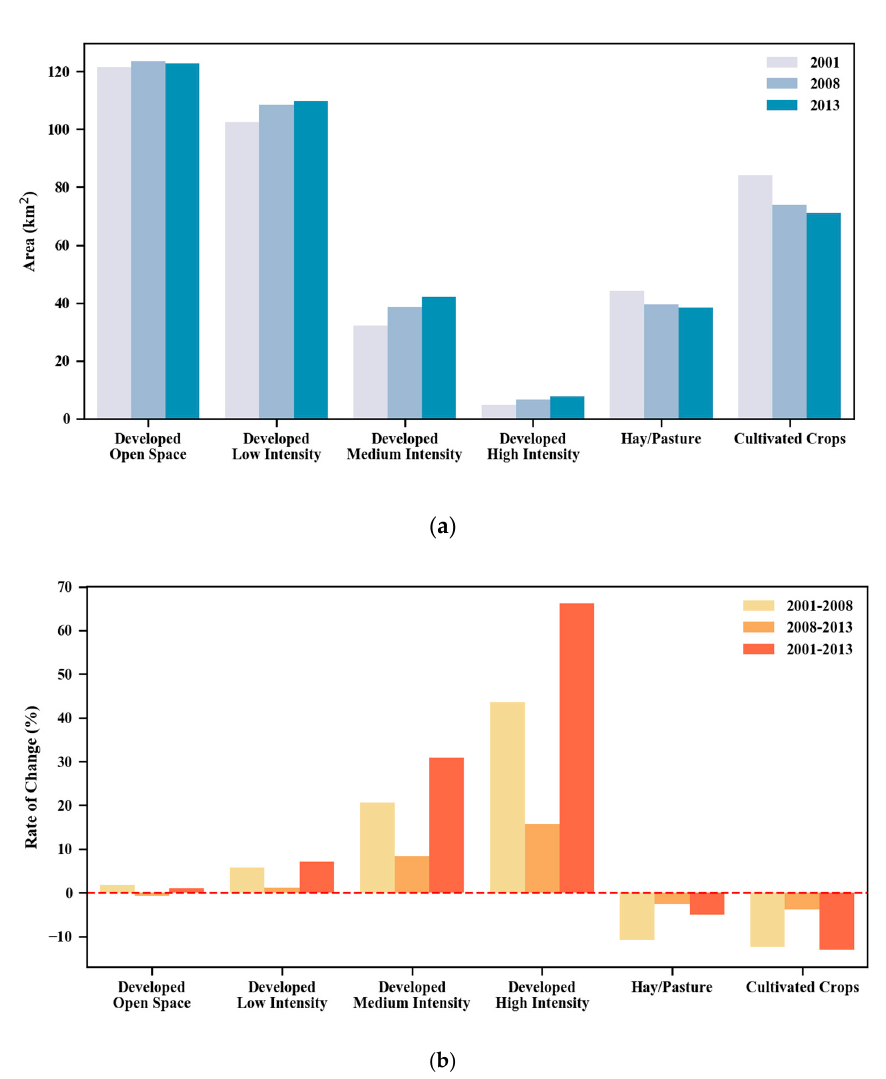
Remote Sens. 2020 , 12 , x FOR PEER REVIEW Figure 9. ( a ) LULC area for 2001, 2008, and 2013 and ( b ) rate of change by the LULC type.